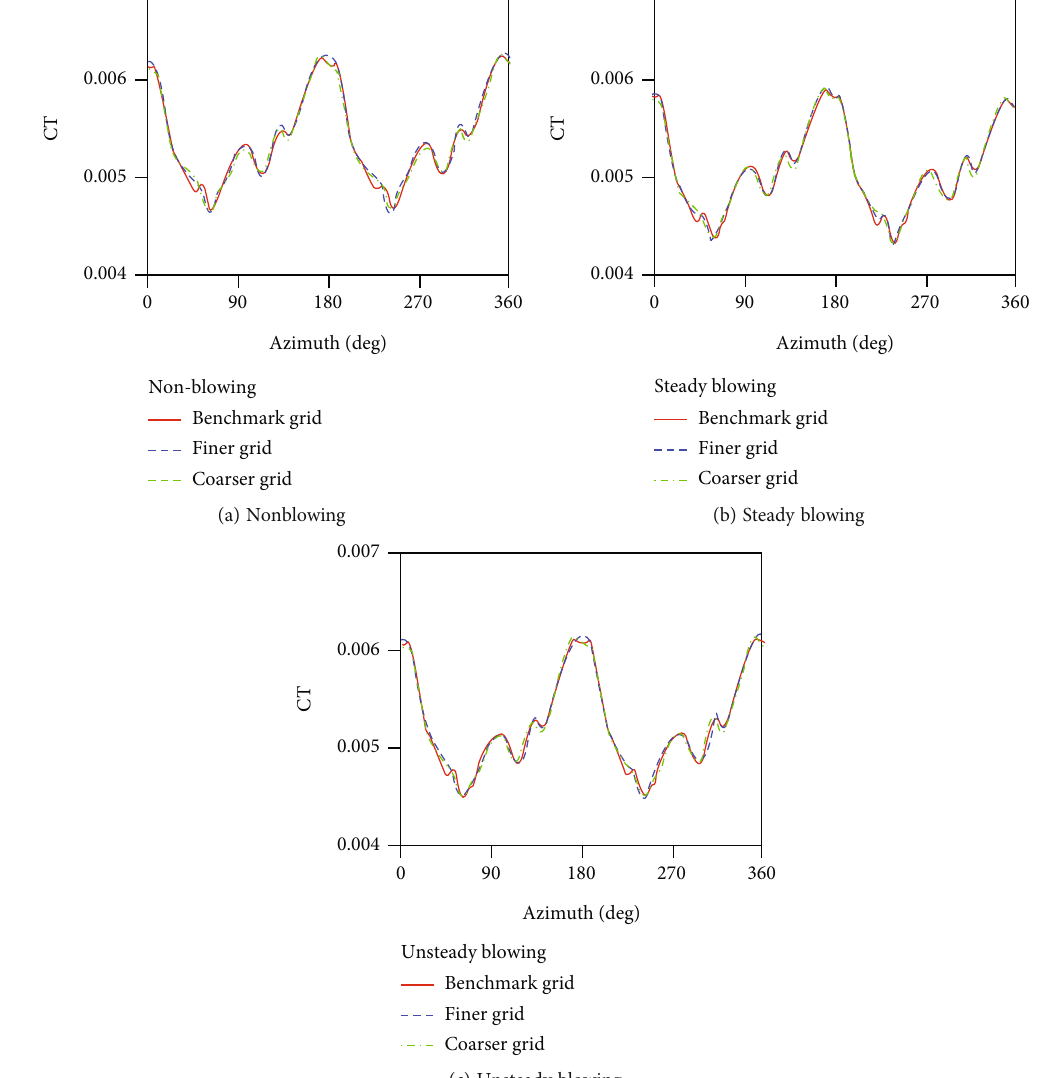
Figure 6: Rotor thrust coe ffi cients with azimuthal angles for the steady/unsteady blowing cases under the three background grid